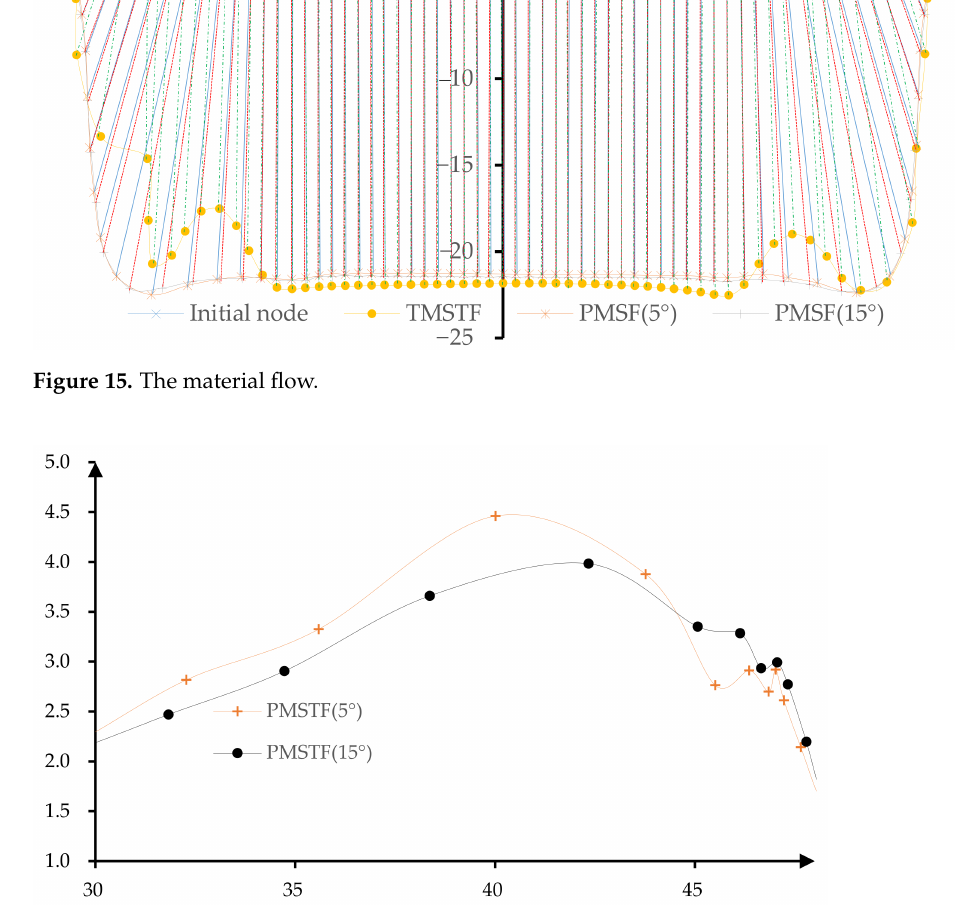
Figure 16. Distance between two adjacent